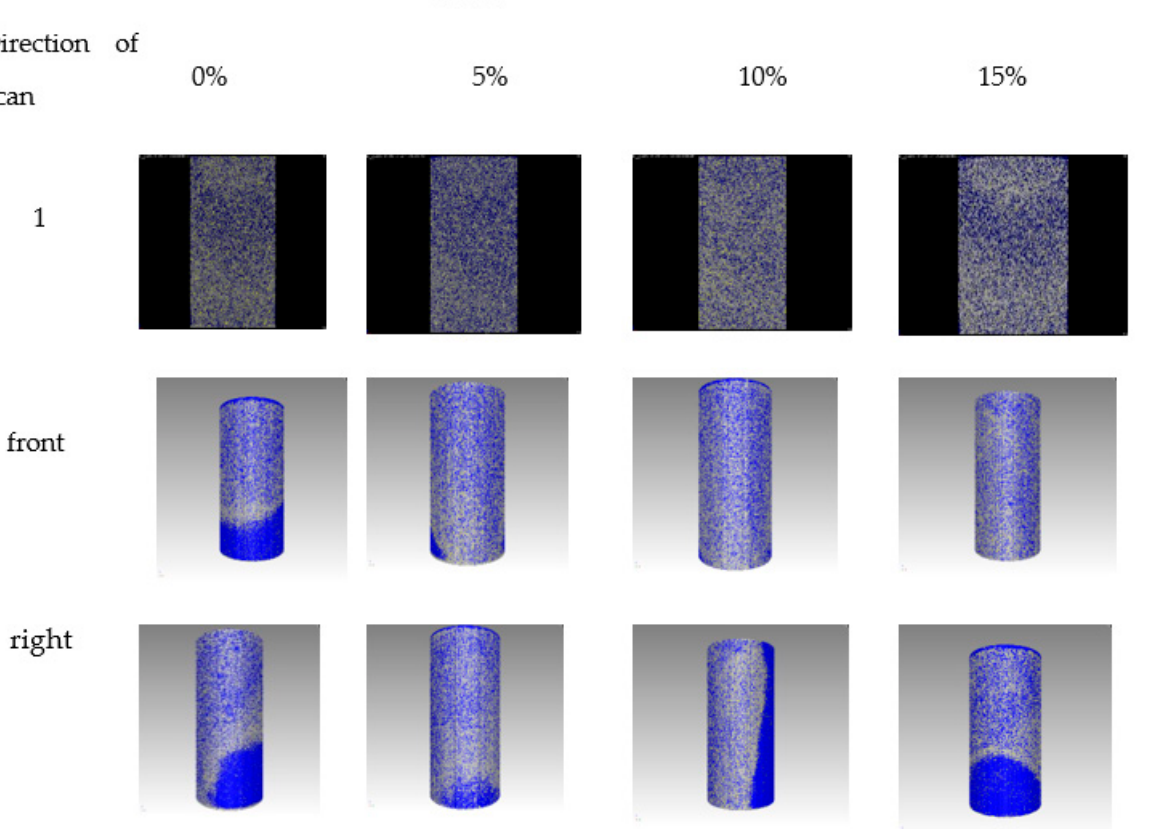
Figure 12. CT images with strain in different direction ( S h = 13%). ‘front’/’right’ and ‘1’ mean the different directions of CT scan to the samples. The color of white indicates sand; the yellow indicates hydrate; the blue indicates gas.